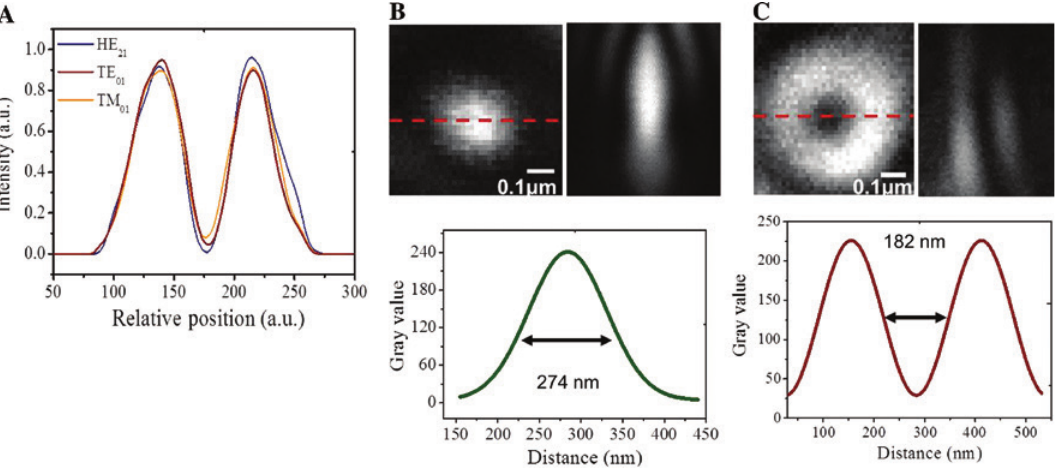
Figure 8: Point spread function of donut and Gaussian beams. (A) Experimentally measured mode field intensity curves of TE and (right) axial-sections, and the line profiles of the cross-section of (B) Gaussian and (C) donut